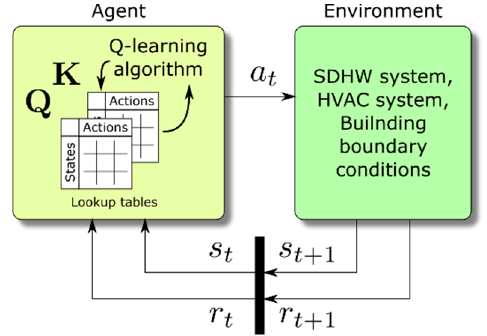
Figure 1. Q-learning scheme.